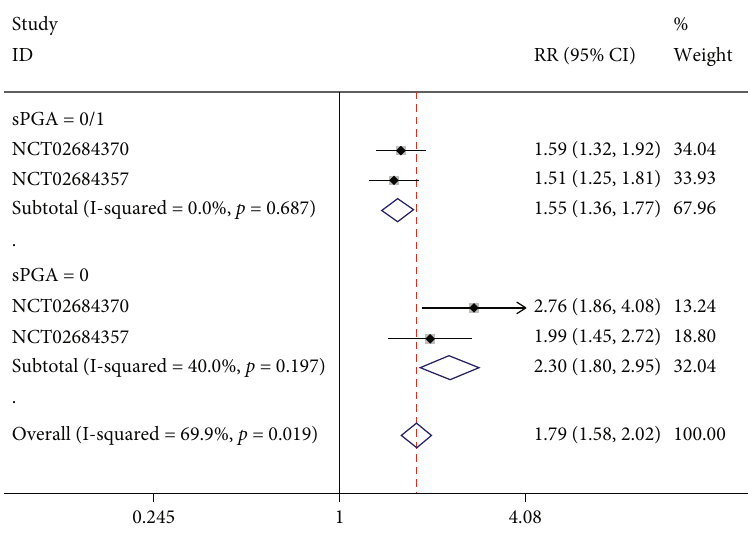
Figure 5: Forest plot of long-term sPGA scores.